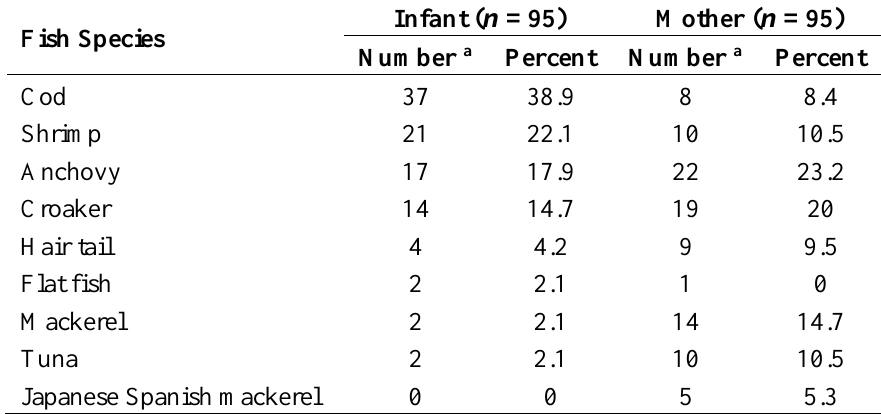
Table S3. Fish species commonly ingested by infants and their mothers enrolled during the 2013/2014 season.